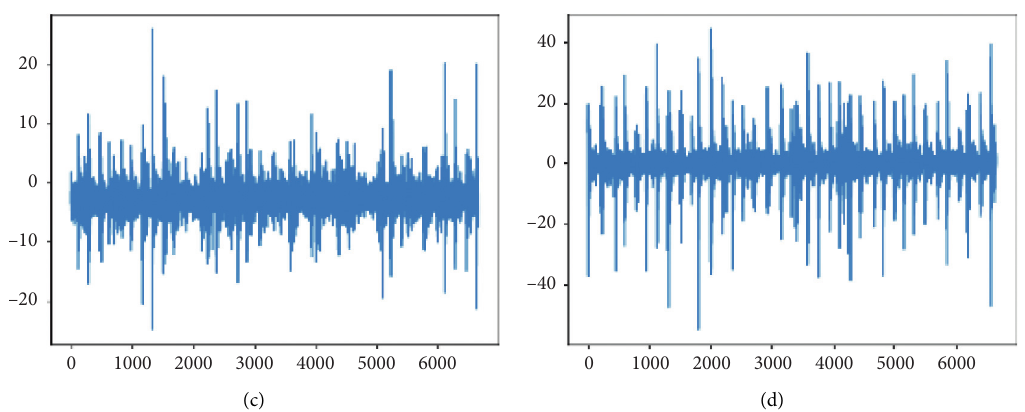
Figure 10: Time-domain waveforms of large gear pitting pinion wear.